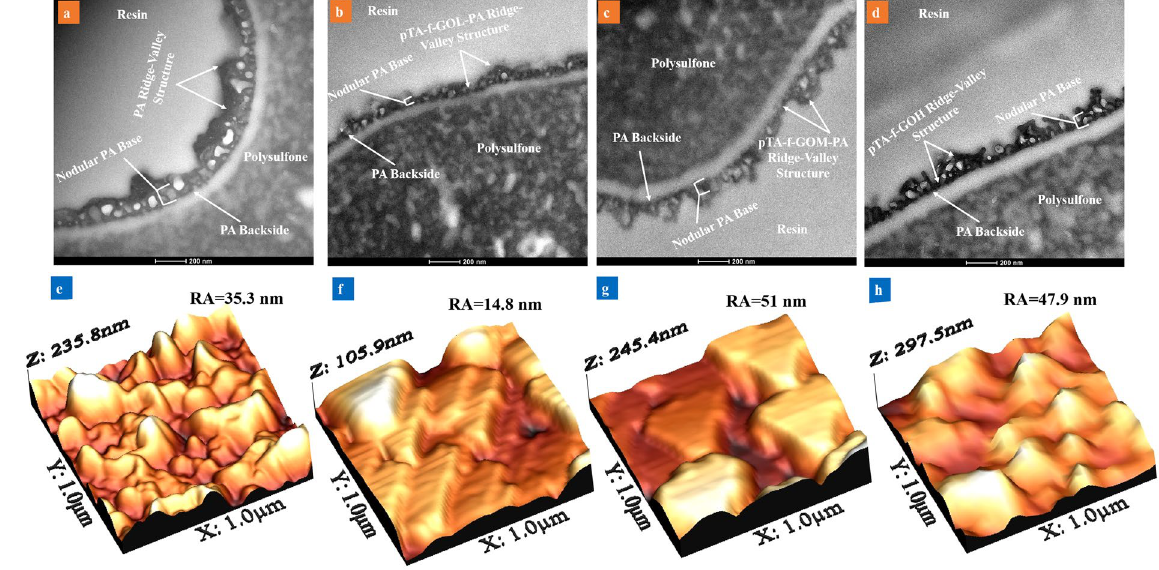
Figure 1. Cross-sectional TEM (scale bar of 200 nm) along with 3D AFM images of the prepared TFC membranes. The membranes were fabricated under the same conditions except the pTA-f-GO nanosheets content.